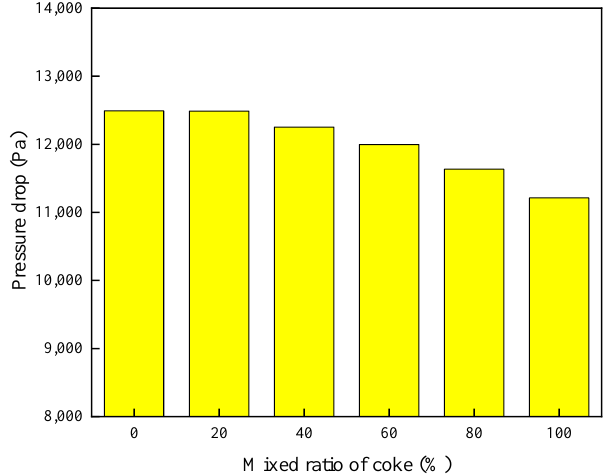
Figure 14. Pressure drop comparison for different mixing ratios.